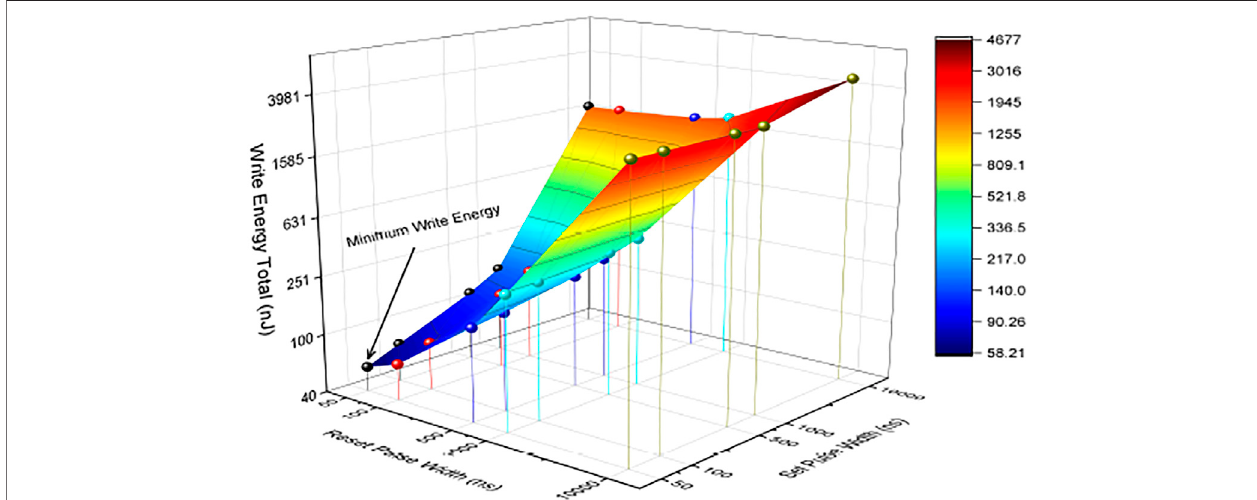
FIGURE 12 | Write energy over different pulse widths.